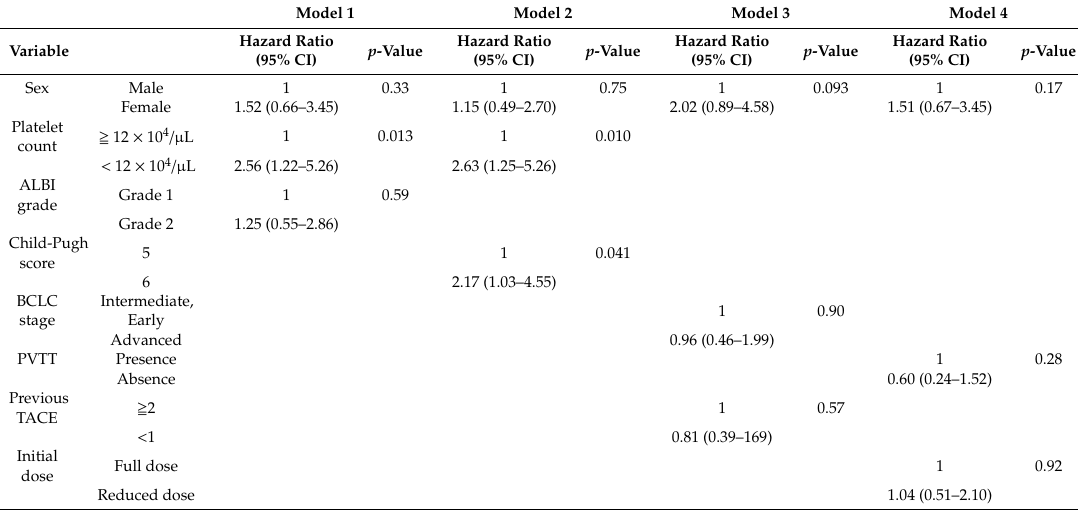
Table 5. Results of a multivariate analysis of factors associated with ascites formation ( n =